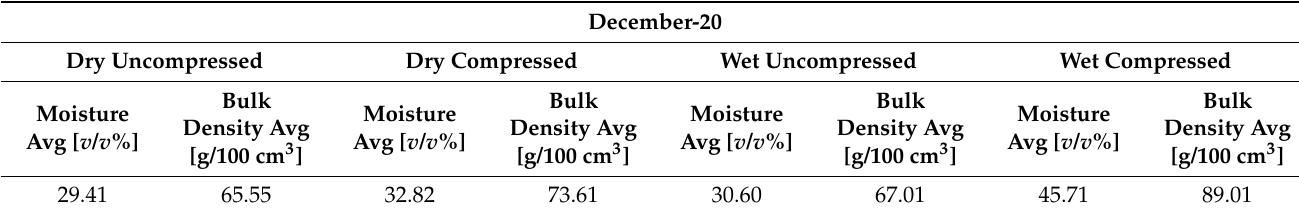
Table 10. Bulk densities of Loam texture soil.